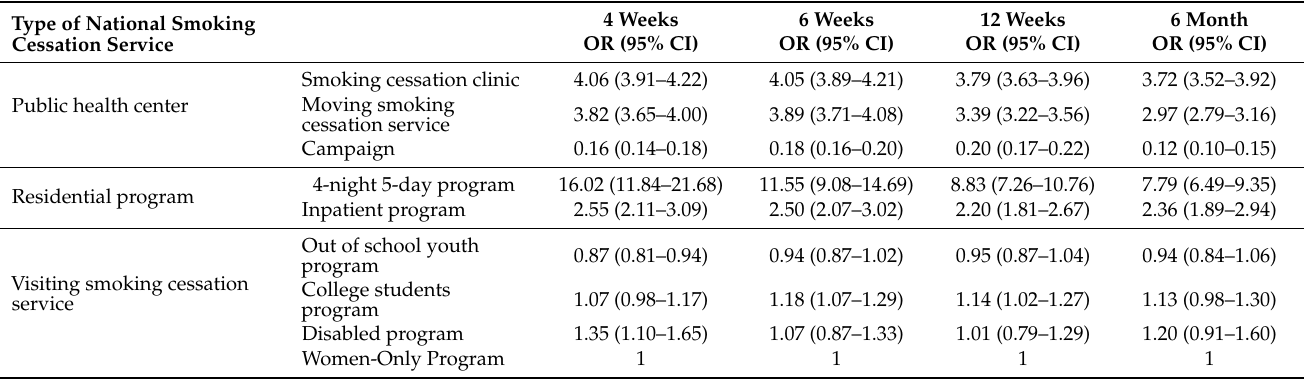
Table 4. Odds ratios for success of smoking cessation according to various smoking cessation program compared with the women-only